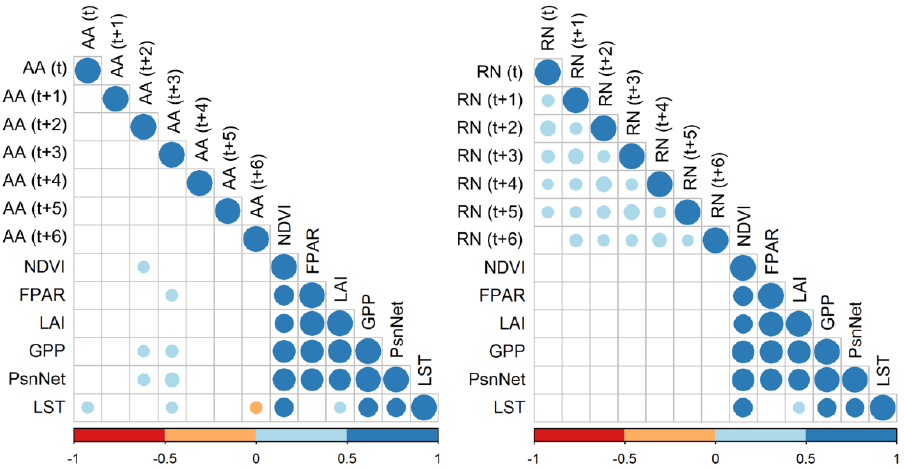
Figure 6. Correlation matrix of environmental factors and capture rate of Apodemus agrarius (left) and Rattus norvegicus (right). Every correlation coefficient that matched two variables was calculated with Pearson’s method in R. AA, Apodemus agrarius ; RN, Rattus norvegicus ; NDVI, normalized difference vegetation index; FPAR, fraction of photosynthetically active radiation absorbed by vegetation; LAI, leaf area index; GPP, gross primary productivity; PsnNet, net photosynthesis; LST, land surface temperature. Numbers ranging from − 1 to 1 are Pearson’s correlation coefficients of variables on horizontal and vertical axes. The color and size of circles indicate the correlation significance. Only significant statistics ( p < 0.05) are shown.